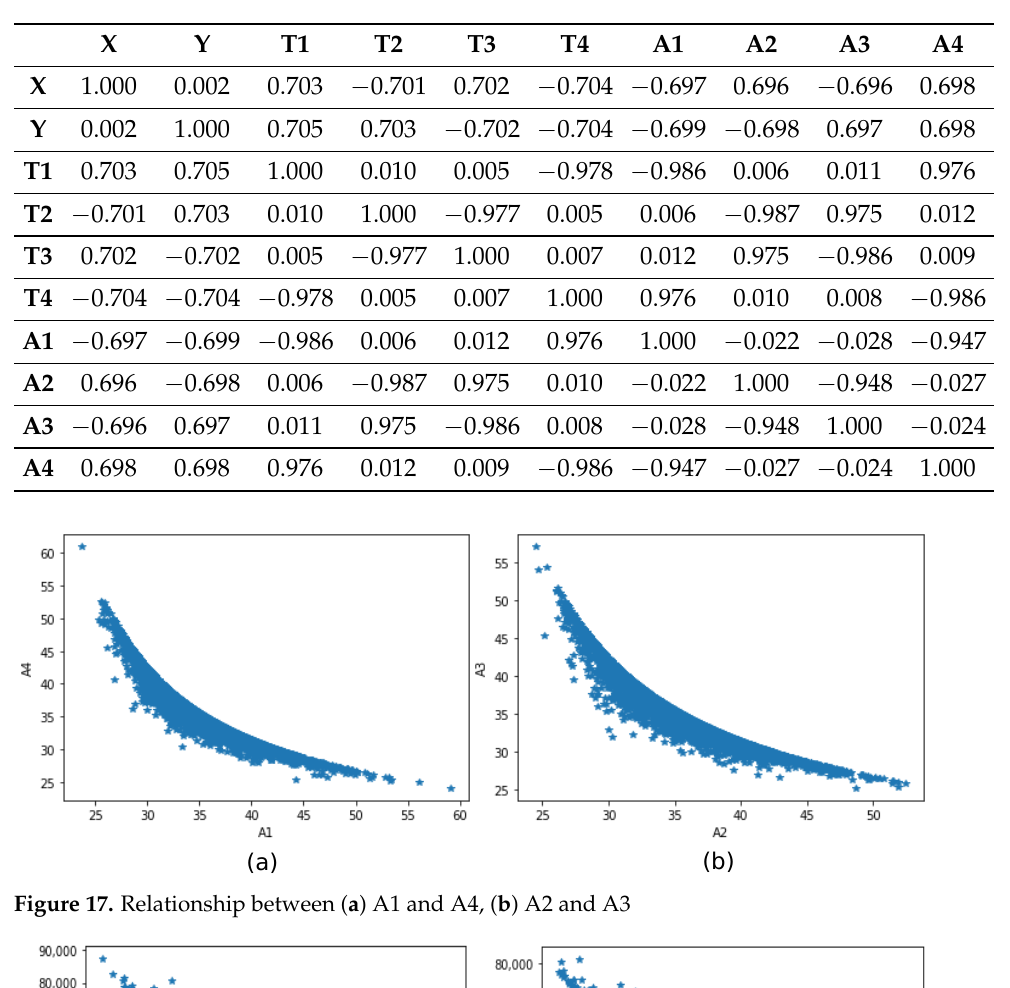
Table 2. Correlation between dataset variables.